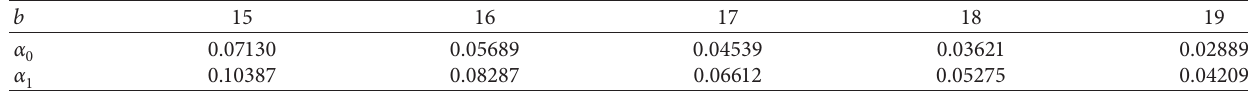
Table 3: Numerical results of α